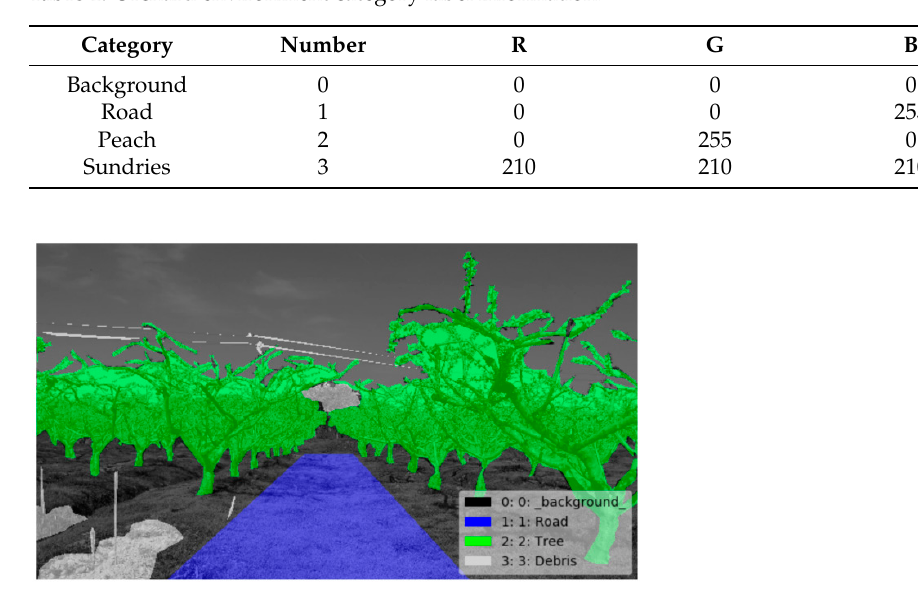
Figure 2. Labeled map of the orchard environment.